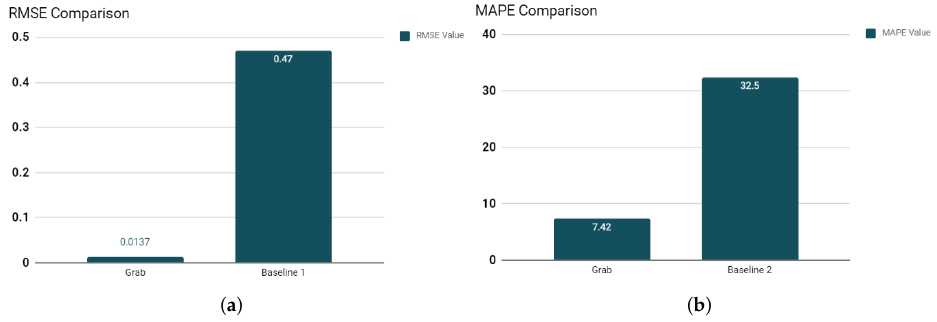
Figure 6. Comparison of the proposed GrAb model and state-of-art approaches. ( a ) Grab —RMSE Comparison. ( b ) Grab —MAPE Comparison.